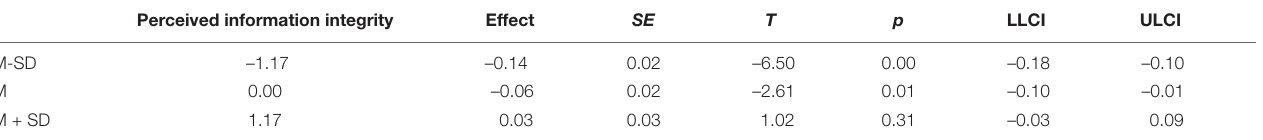
TABLE 5 | Moderated mediating effect.